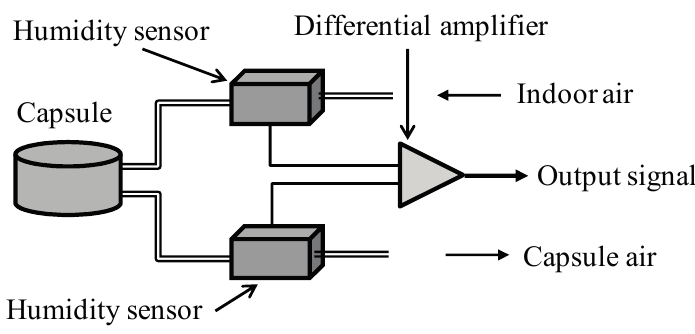
Figure 2. Schematic of the digital perspiration meter.